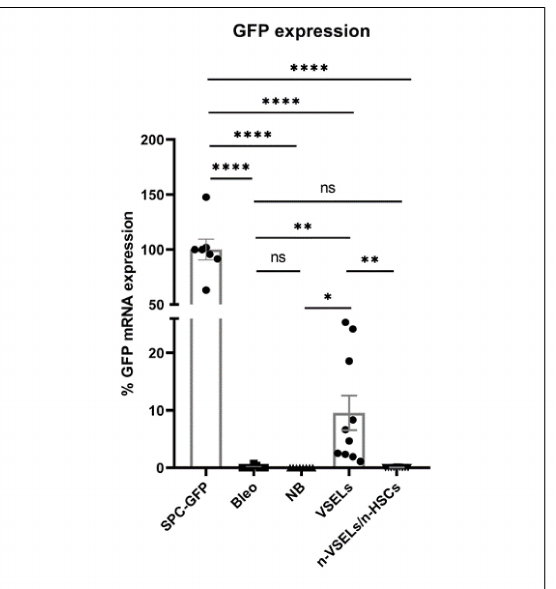
Figure 3. Relative GFP mRNA expression. Lung tissue from SPC-GFP (donor) mice was used as the reference point for GFP expression. Y axis shows relative ∆ CT. Statistically significant differences between Bleo group and selected populations are indicated. Results are from 3 experiments. Mean